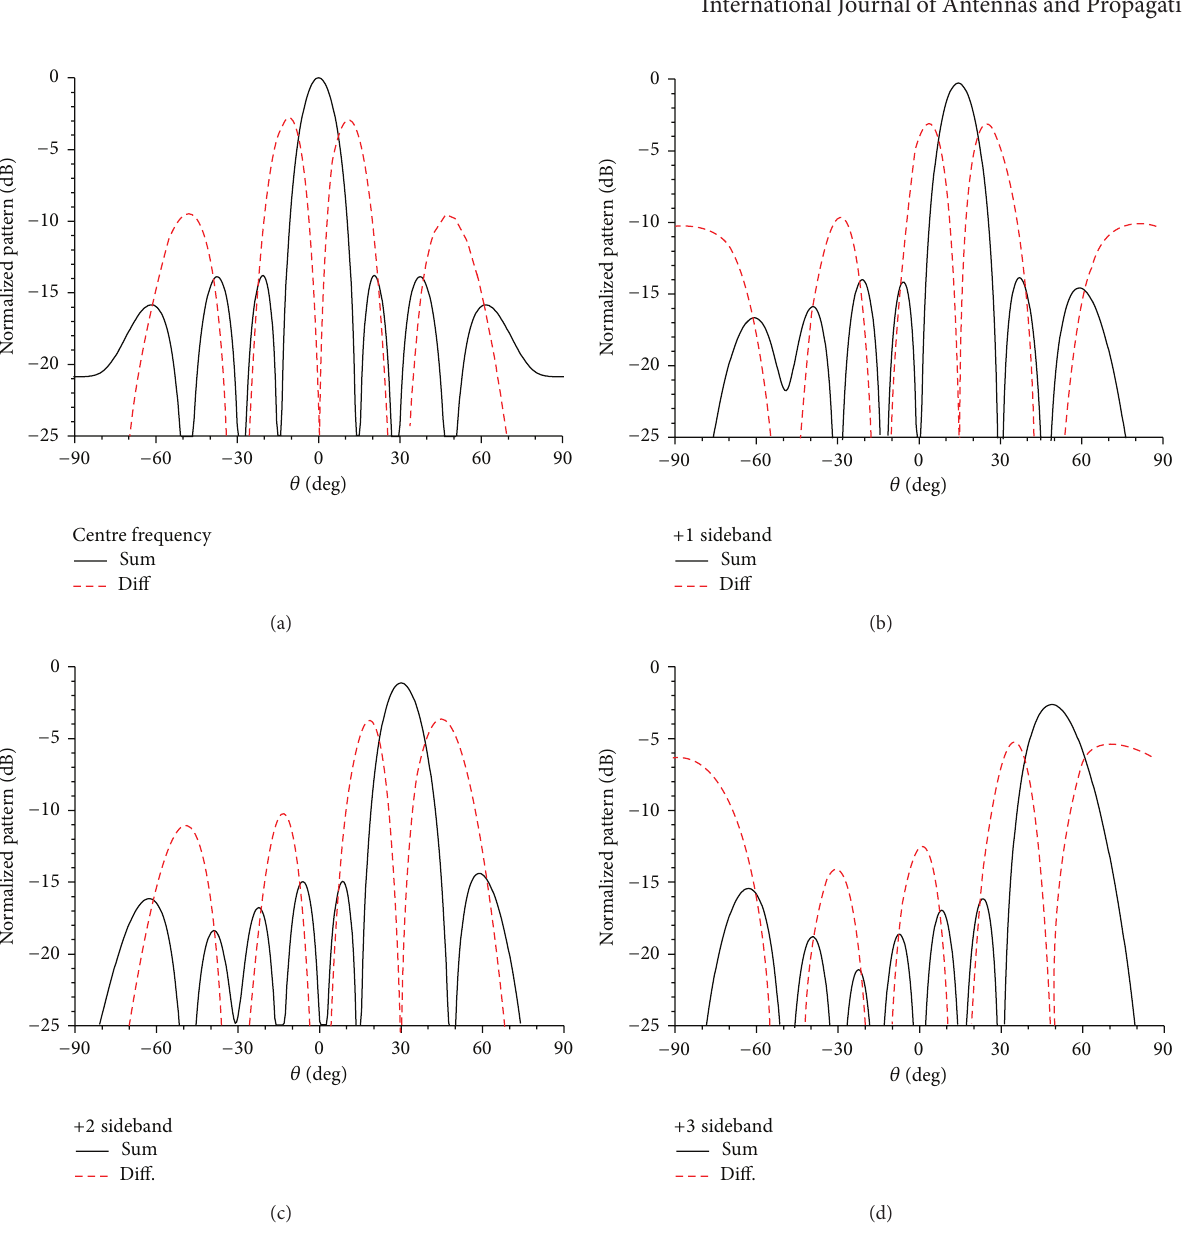
Figure 8: The sum-difference patterns formed at different sidebands and different pointing directions by phase-comparing the multibeams of subarray 1 and subarray 2 (only the positive sidebands are